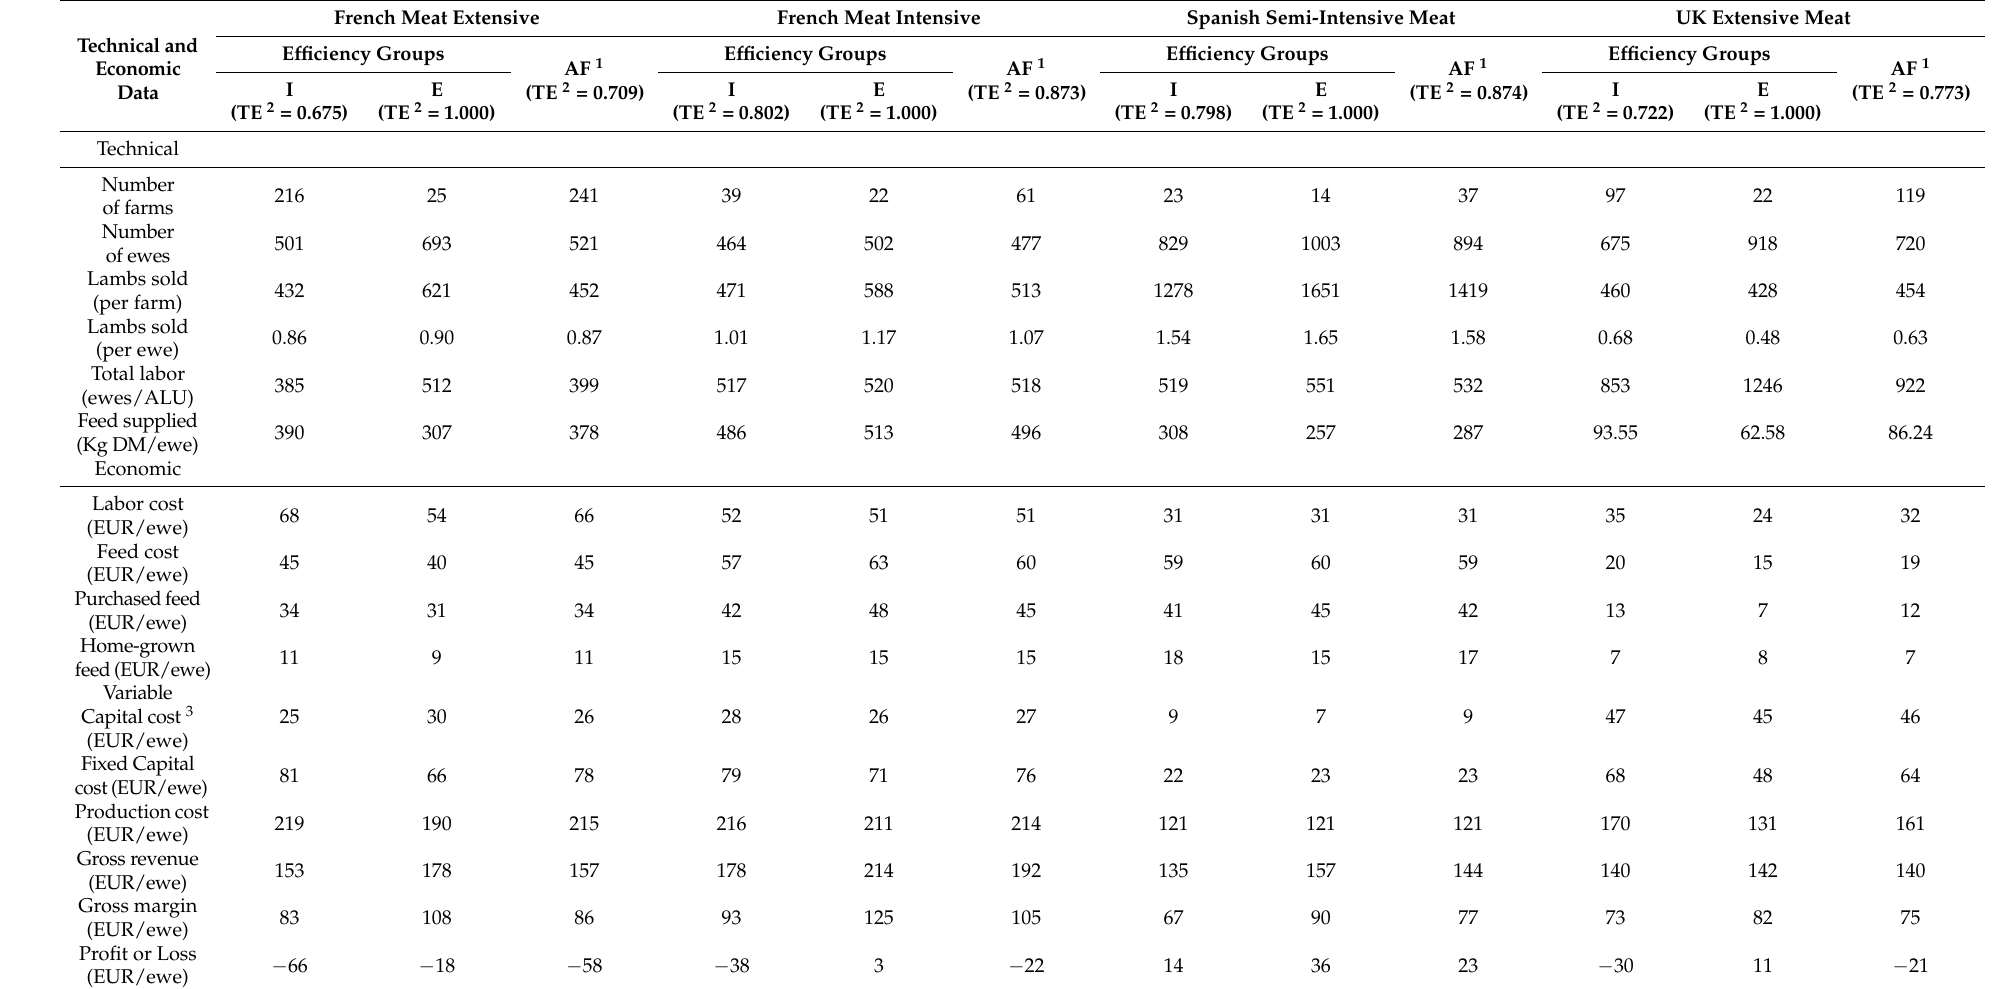
Table 4. Technical and economic characteristics of the technical efficient (E) and inefficient (I)